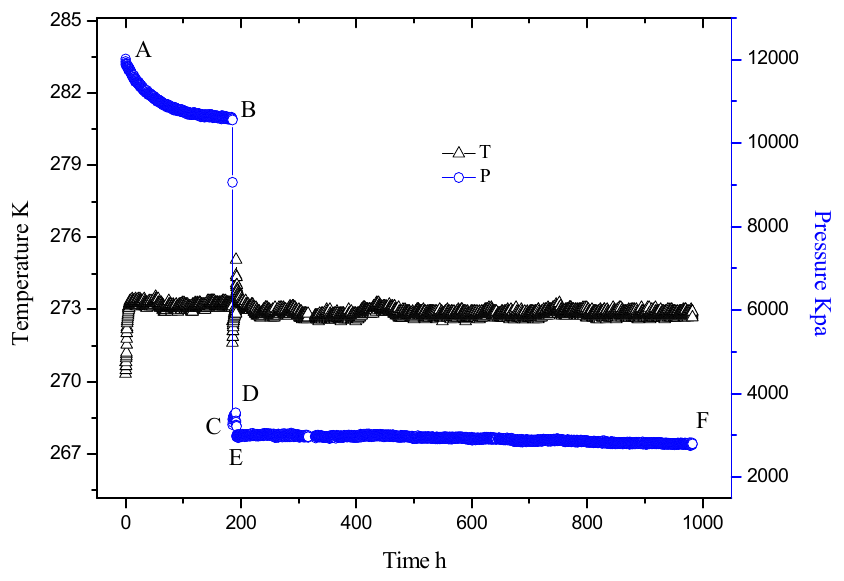
Figure 2. The evolvement of system pressure and temperature with the elapsed time during experiment Run 1. A–B, period of hydrate formation; B–C, depressurization above dissociation pressure of methane hydrate; C–D, flooding process of free CH D–E, beginning stage of the replacement of CH of